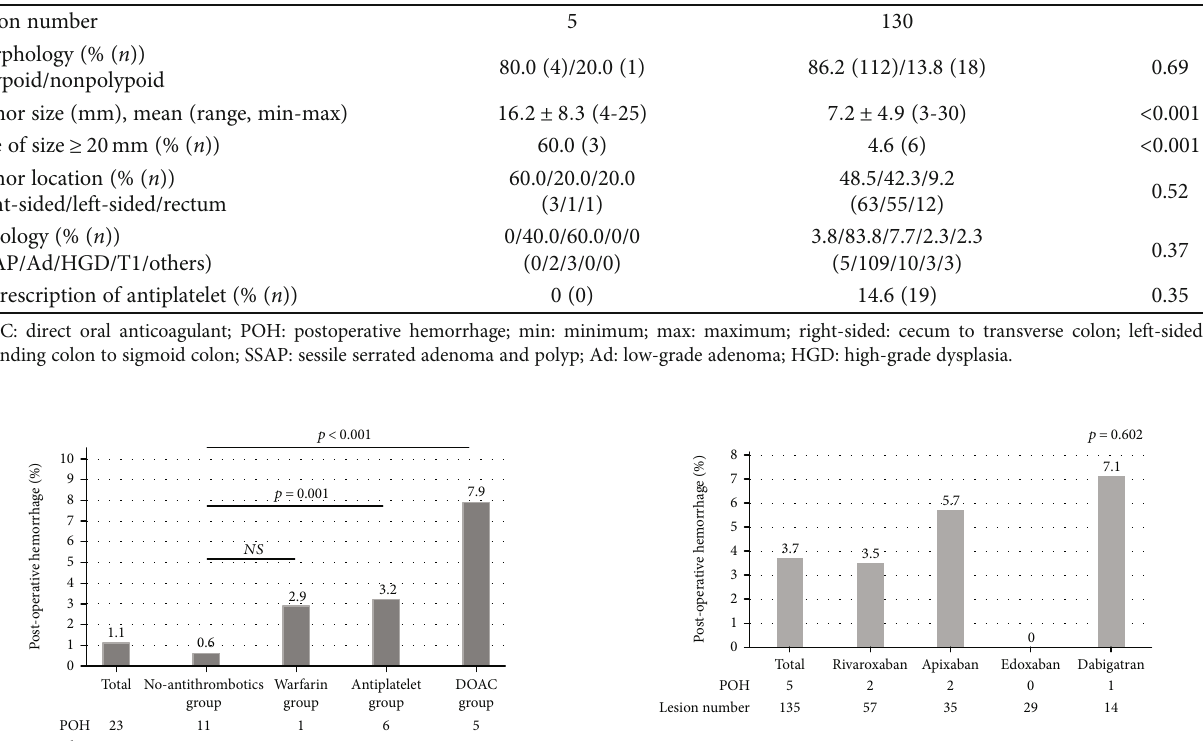
Table 2: The comparison between cases with and without POH after endoscopic mucosal resection in patients with DOACs. DOAC users POH